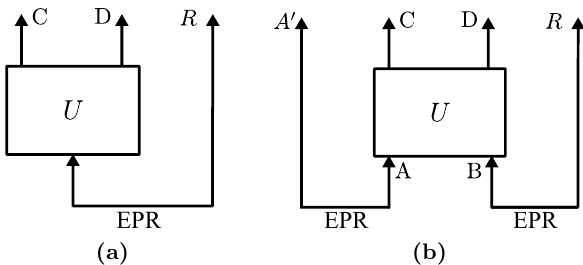
Figure 1 . The notation used in the paper. Here U represents the unitary time-evolution of the black hole. (a) The AMPS thought experiment. C : the remaining black hole. D : the outgoing mode. R : the early radiation. (b) The Hayden-Preskill thought experiment. A 0 : the reference. A : the input quantum state. B : the initial black hole. R : the early radiation. C : the remaining black hole. D : the outgoing mode. Horizontal lines represent that two subsystems are in the EPR P d pairs: 1 p j j j =1 j d i (cid:10) j i